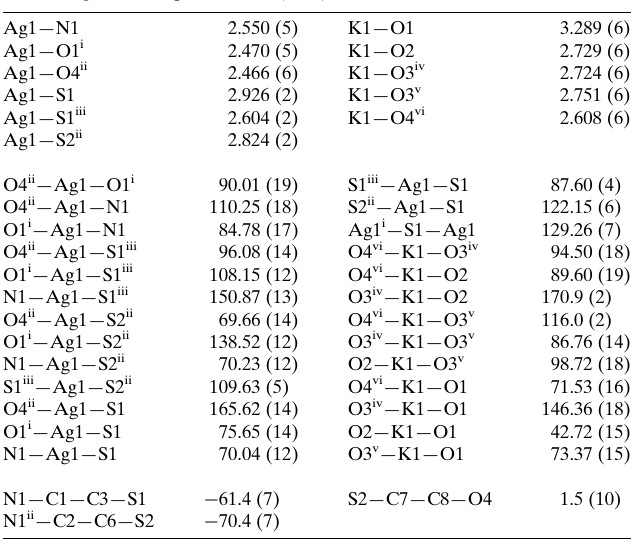
Table 1 Selected geometric parameters (A˚ , (cid:5) ).